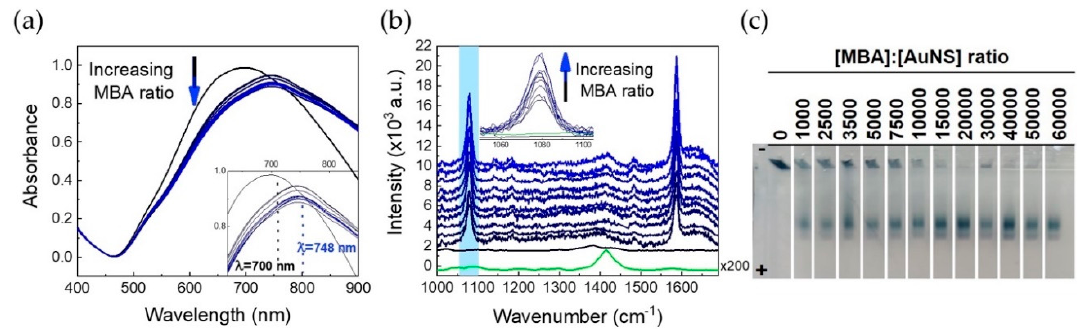
Figure 3. Analysis of MBA-functionalized AuNSs by UV-Vis spectroscopy, SERS, and AGE. ( a ) Normalized UV-Vis spectra of AuNSs functionalized with increasing MBA molar ratios. Comparing the LSPR bands of AuNSs capped with citrate from the synthesis (black line), with AuNSs functionalized with increasing molar ratios of MBA (blue lines), a bathochromic shift of 48 nm is observed. ( b ) SERS spectra of functionalized AuNSs, presented increasingly more intense lines at 1079 cm − 1 (inset) and 1587 cm − 1 , which confirmed changing the capping agent by disappearing citrate lines and appearing MBA lines, since the molar ratio of MBA increases. Citrate SERS spectrum is presented in green, for comparison ( c ). Photograph of an agarose gel with AuNSs samples functionalized with increasing molar ratios of MBA.